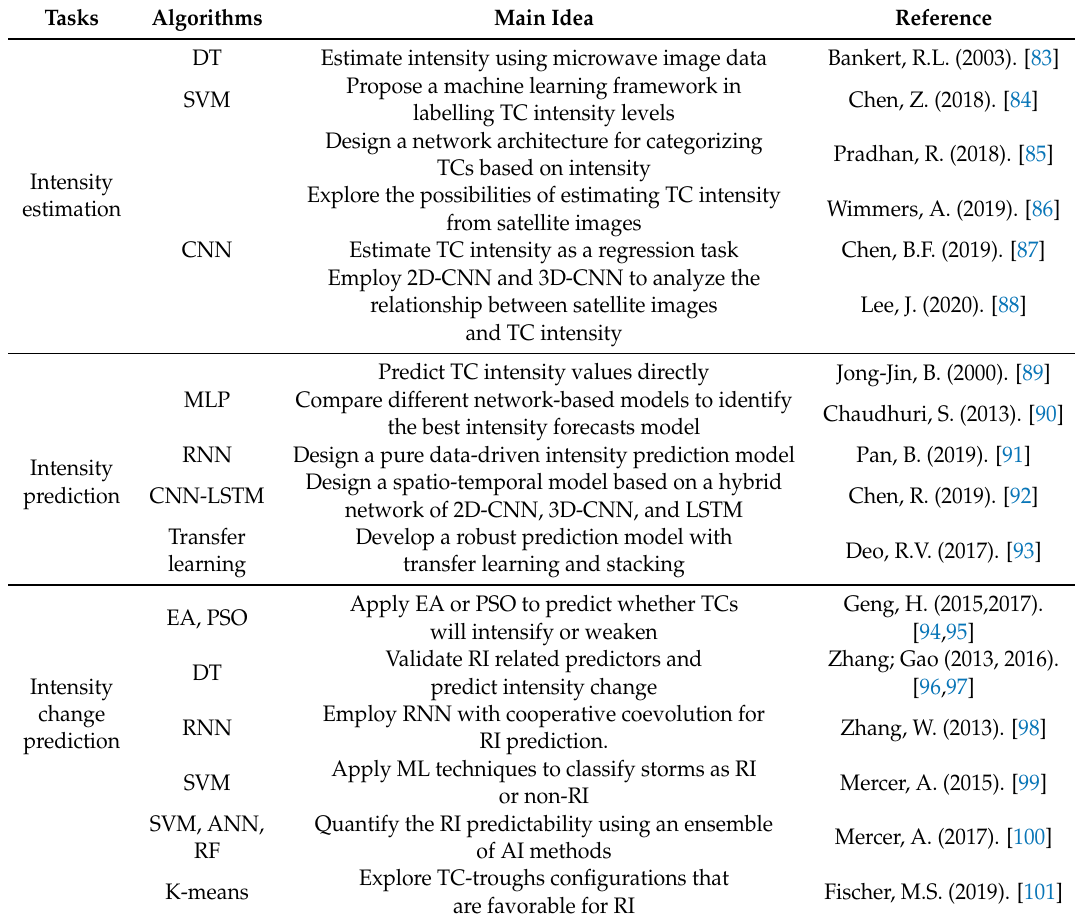
Table 3. Machine learning in TC intensity